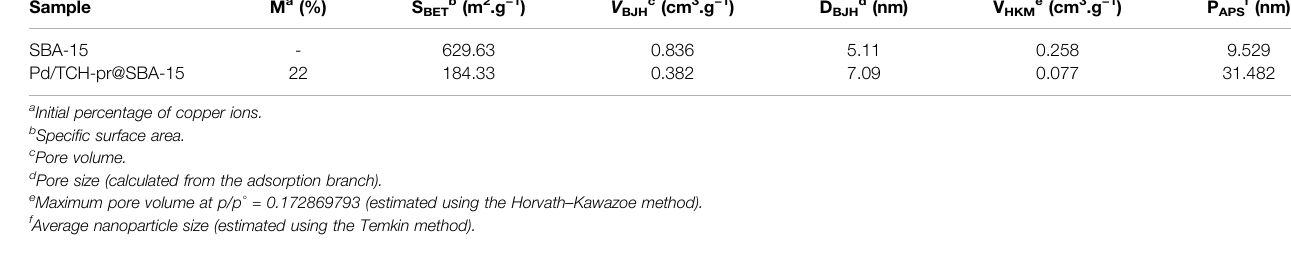
TABLE 1 | Structural and textural parameters of the SBA-15 and Pd/TCH@SBA-15 composites. Sample